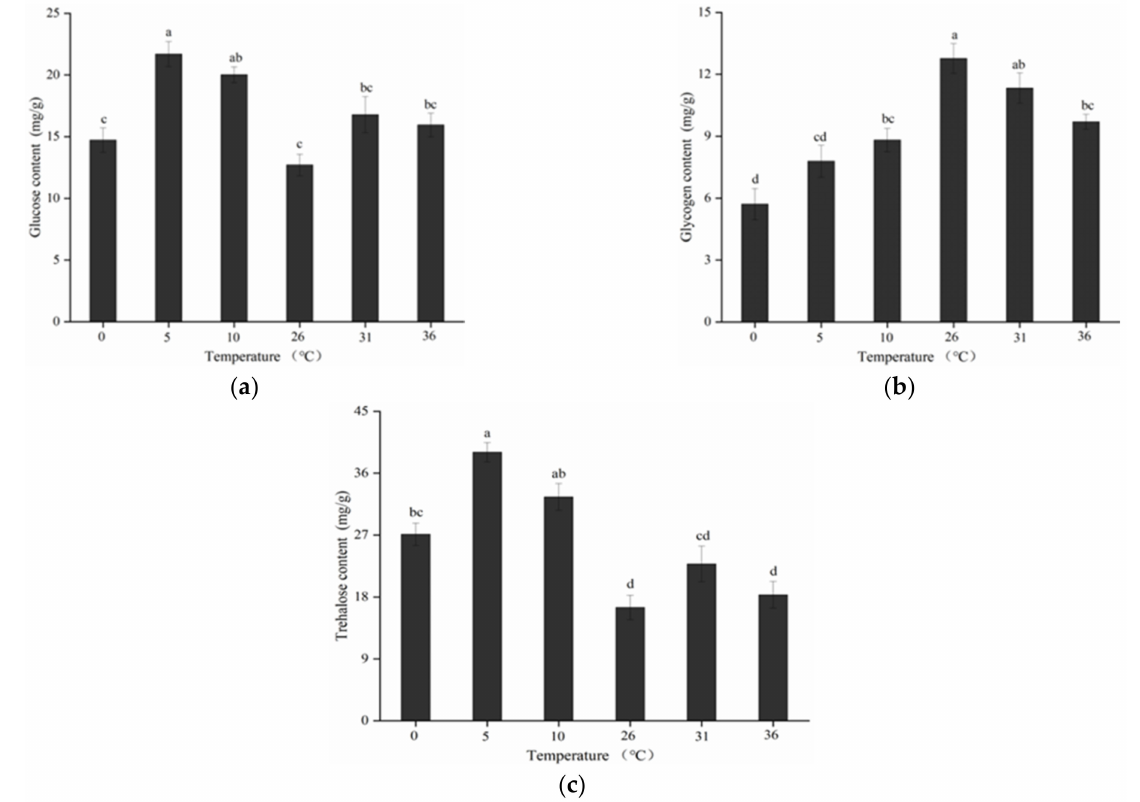
Figure 5. Glucose ( a ), glycogen ( b ), and trehalose ( c ) levels of adult B. dorsalis exposed to various short-term high- and low-temperature treatments. Data are presented as means ± standard errors of five replicates. Different lowercase letters indicate significant differences ( p < 0.05, Tukey’s